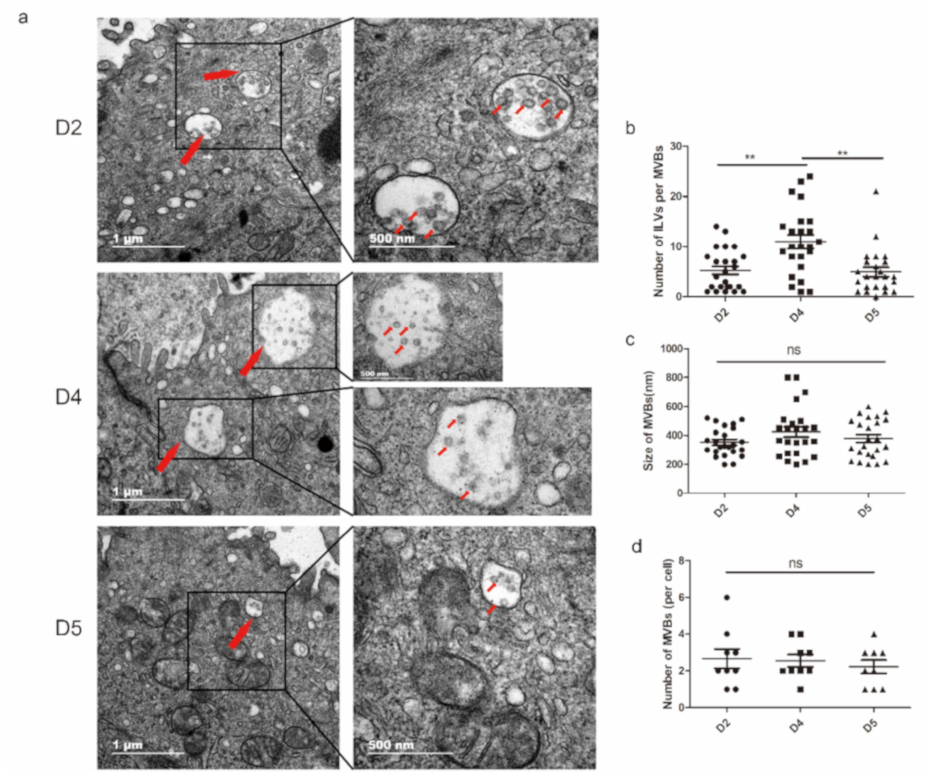
Figure 1. MVBs are present in mouse endometrium cells during early pregnancy. ( a ) Representative electron microscopic images of endometrium tissues on D2, D4, and D5 of pregnancy: Red arrows indicate MVBs including classic intraluminal vesicles (ILVs). ( b ) The number of ILVs per MVB, ( c ) size of MVBs, ( d ) number of MVBs per cell in di ff erent stages: MVBs were counted only when containing typical ILVs. ** P < 0.01. ns: not